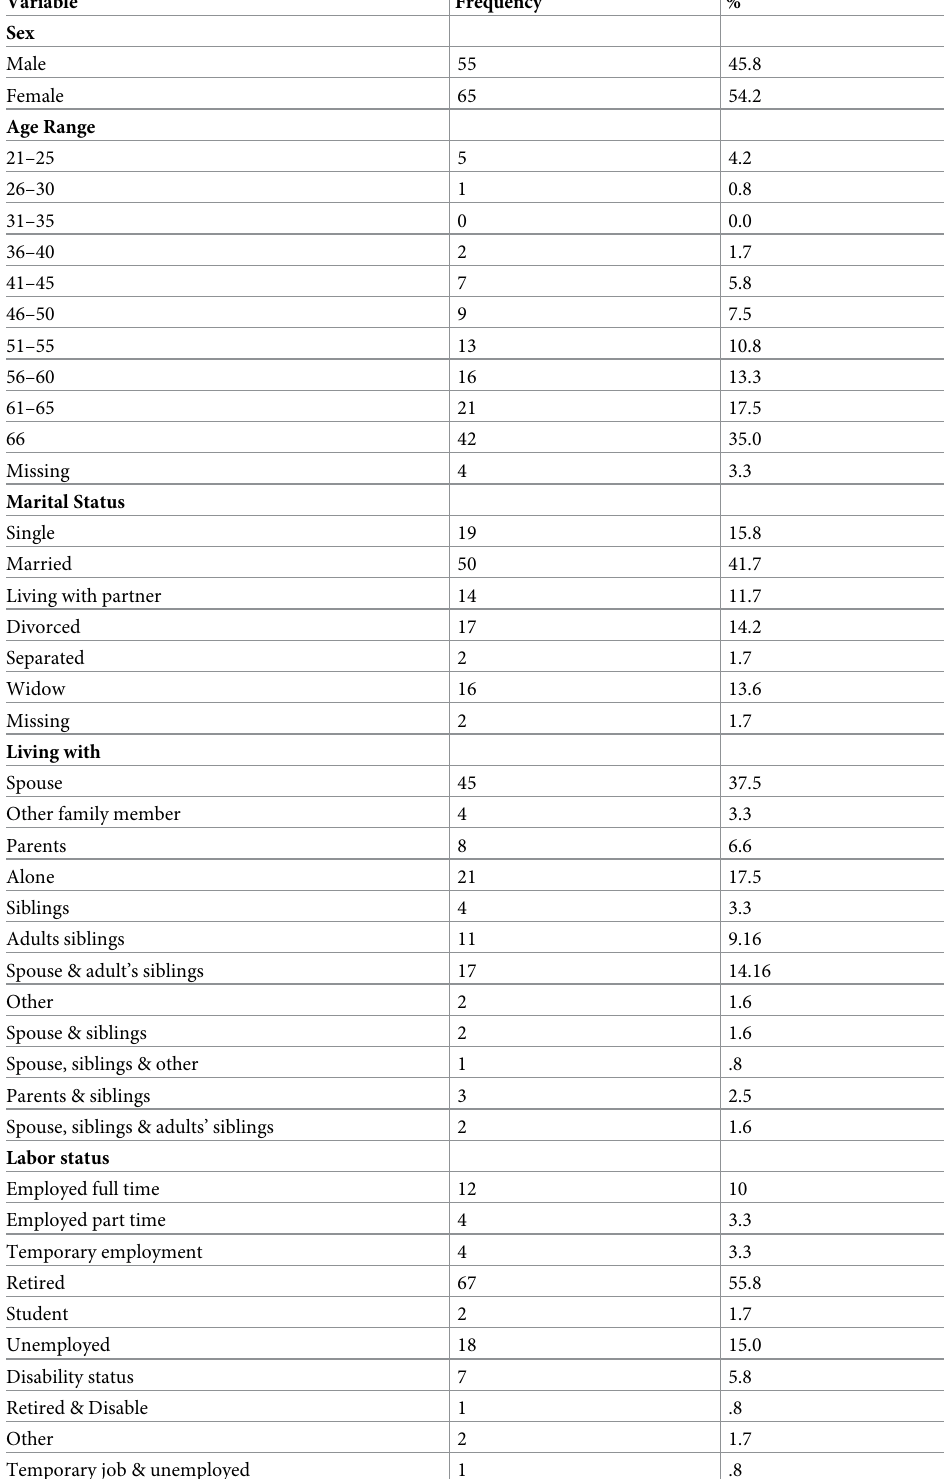
Table 1. Sociodemographic and clinical characteristics (n =